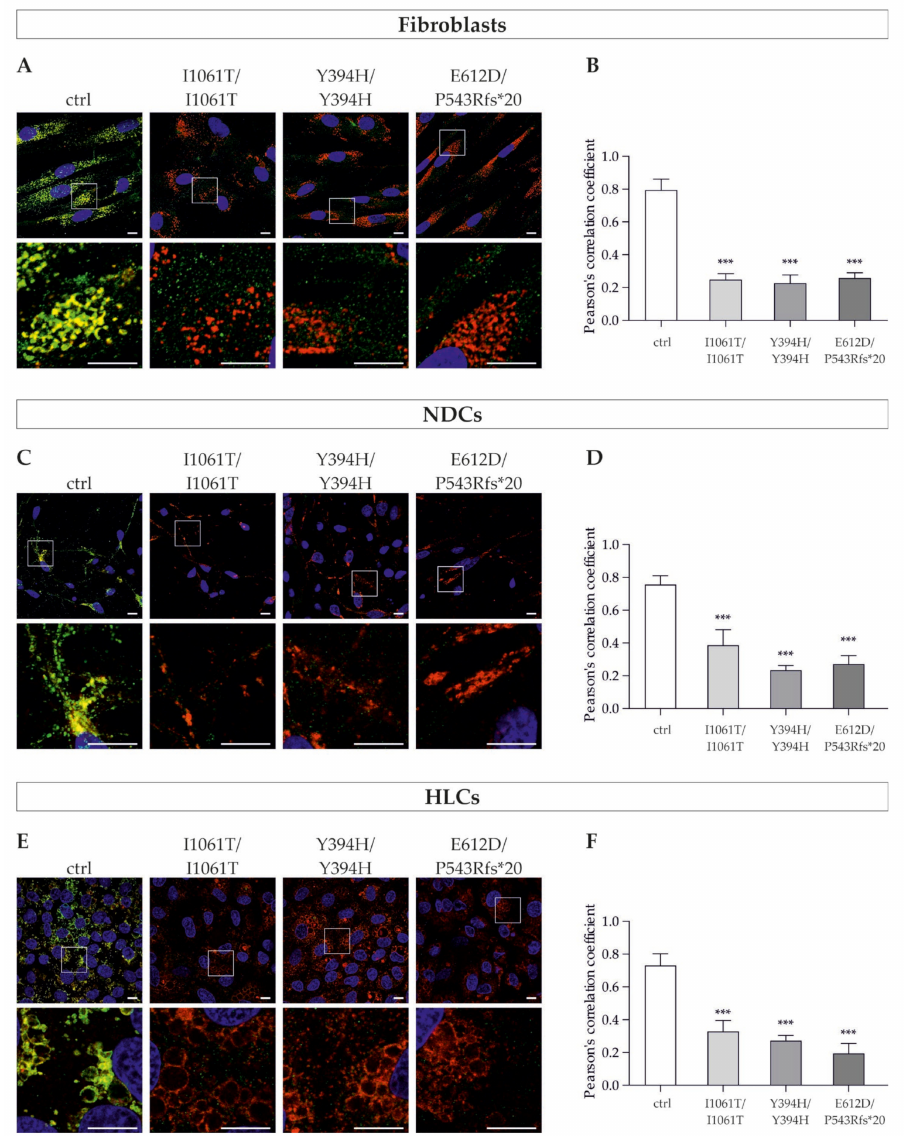
Figure 5. Intracellular localization of NPC1 protein in patients’ fibroblasts, neural differentiated, and hepatocyte-like cells. ( A , C , E ) Representative confocal images of immunofluorescence staining for NPC1 (green) and lysosomal marker LAMP2 (red) in fibroblasts, neural differentiated cells, and hepatocyte-like cells, respectively. DAPI was used to counterstain nuclei (blue). Magnified images of the squared region of each image are shown below each one. In cells of the control cell line, NPC1 was strongly expressed as seen by cytoplasmic puncta, which appear to strongly colocalize with LAMP2. In contrast, the overall fluorescent NPC1 signal intensity is very low in NPC1-deficient cells and visible colocalization with LAMP2 could not be observed, indicating massively reduced levels of NPC1 in the lysosomes of the cells. Scale bar = 10 µ m. ( B , D , F ) Quantification of Pearson’s correlation coefficient revealed a weak NPC1/LAMP2 colocalization in all cell types of the NPC1-deficient cell lines, demonstrating a reduced amount of NPC1 protein in the lysosomes. N = 8. *** = p < 0.001 by one-way ANOVA, followed by the Dunnett’s post hoc test compared to ctrl. NDCs = neural differentiated cells; HLCs = hepatocyte-like